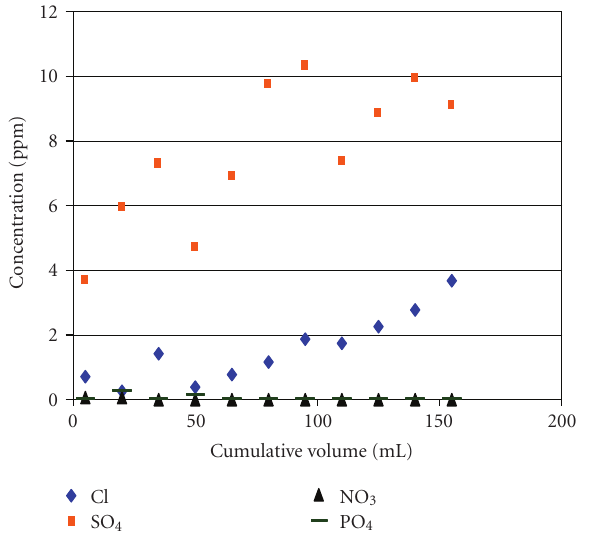
Figure 11: Breakthrough results for DOWEX ion exchanger using 50 ppm Cl, SO 4 , NO 3 , and PO 4 .